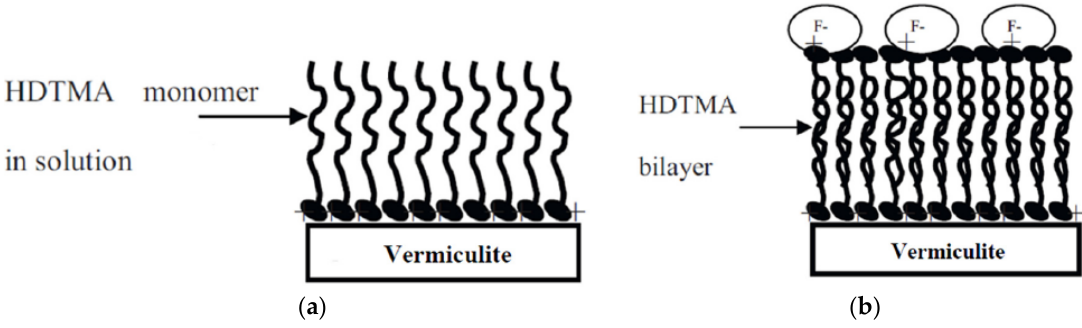
Figure 2. Monolayer ( a ) and bilayer ( b ) arrangement of HDTMA. Reproduced with permission from [26], Elsevier, 2012